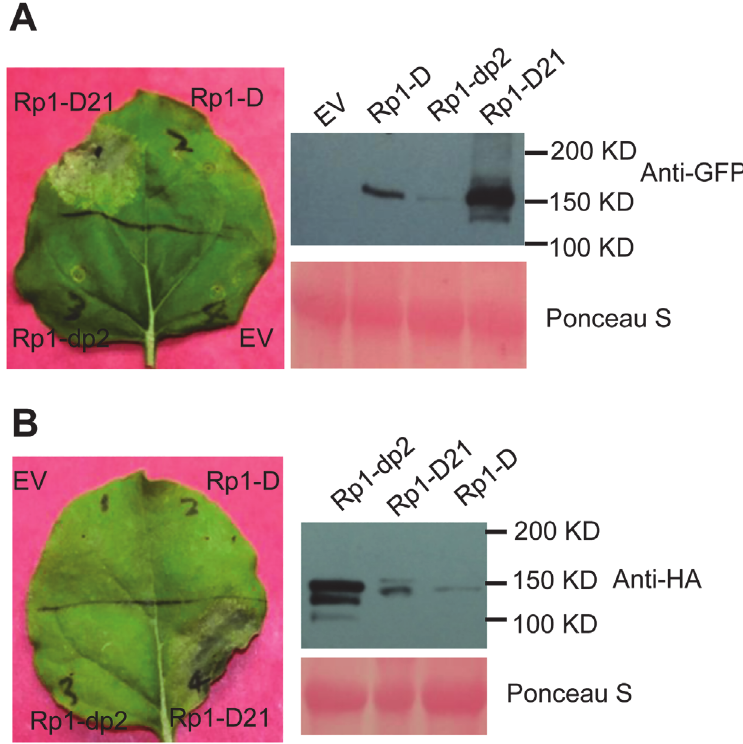
Fig 3. Rp1-D21 triggers a hypersensitive response phenotype when transiently expressed in N . benthamiana . (A) Rp1-D21, Rp1-D and Rp1-dp2 proteins fused with a C-terminal EGFP tag were agro- infiltrated into N . benthamiana , with an empty vector (EV) as a negative control. A representative leaf was photographed at 3 days post infiltration (dpi, left). Total protein was extracted from agro-infiltrated leaves at 30 hours post infiltration (hpi), and anti-GFP antibody was used to detect the expression of the fused proteins (right). The sizes of the proteins were labeled on the right. Equal loading of protein samples was shown by Ponceau-S staining of the Rubisco subunit (below, right). (B) Rp1-D21, Rp1-D and Rp1-dp2 proteins fused with a C-terminal 3×HA tag were agro-infiltrated into N . benthamiana , with empty vector (EV) as a negative control. A representative leaf was photographed at 3 dpi (left). Total protein was extracted from agro- infiltrated leaves at 30 hpi, and anti-HA antibody was used to detect the expression of the fused proteins. Equal loading of protein samples was shown by Ponceau-S staining of Rubisco subunit (below, right). These experiments were repeated three times with the same